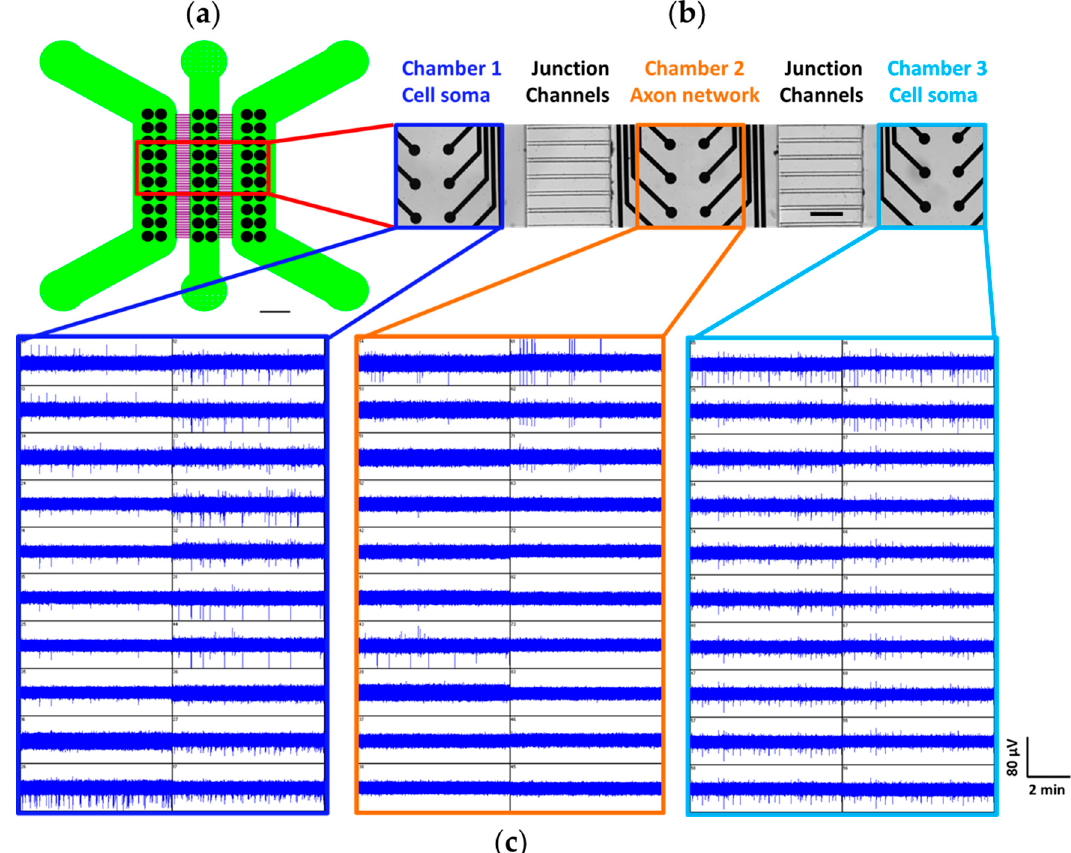
Figure 6. ( a ) Schematic of the chambers and junction channels from the PDMS device and the six columns of electrodes from the MEA device. Scale: 1000 µ m; ( b ) Picture of the interface of PDMS and SU-8 from the device taken by wide field microscope. The functions of each part are indicated. Scale: 200 µ m; ( c ) Neural activities recorded by 60 microelectrodes from this microfluidic-MEA device. The colors are correlated to the regions with the same colors in ( b ). Each sub-window corresponds to one individual electrode. The signals from Chambers 1 and 3 were recorded from cell soma region, and the axon activities were recorded by the electrodes from Chamber 2.